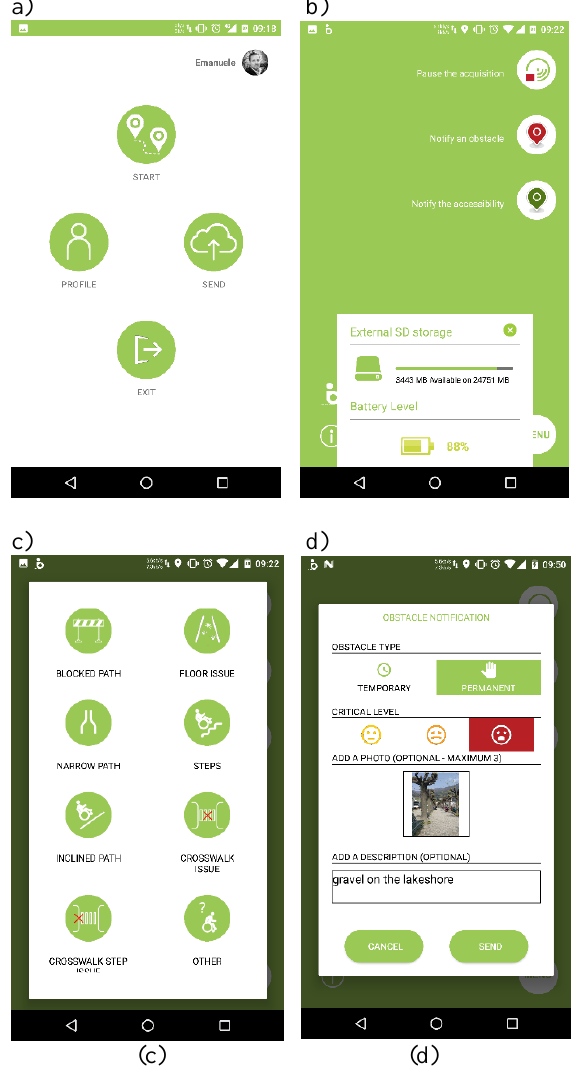
Figure 2. Some snapshots of the MEP Traces app (a) main menu, (b) sensor recording, (c) obstacle type selection, (d) obstacle description and notification.